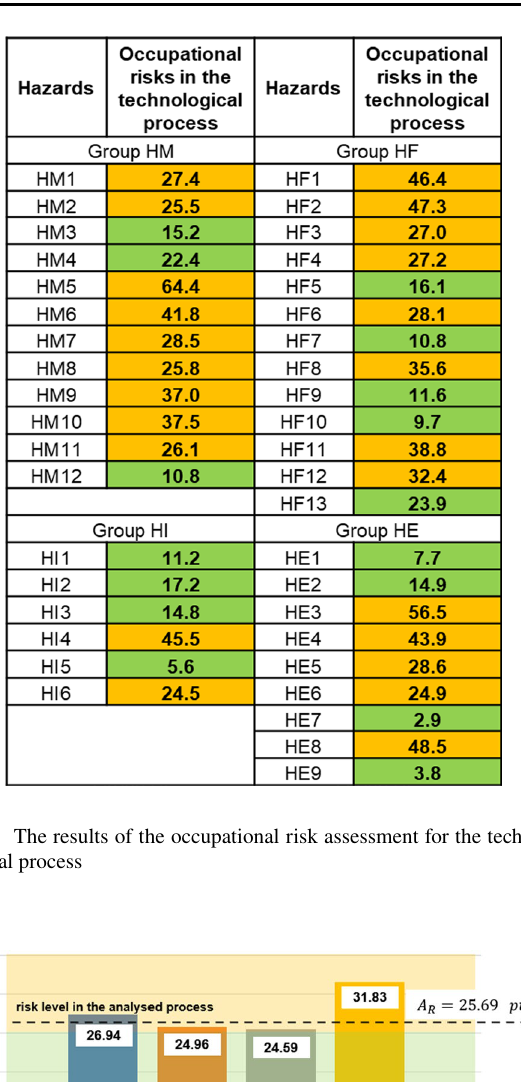
Fig. 9 The minimized level of risk ( M